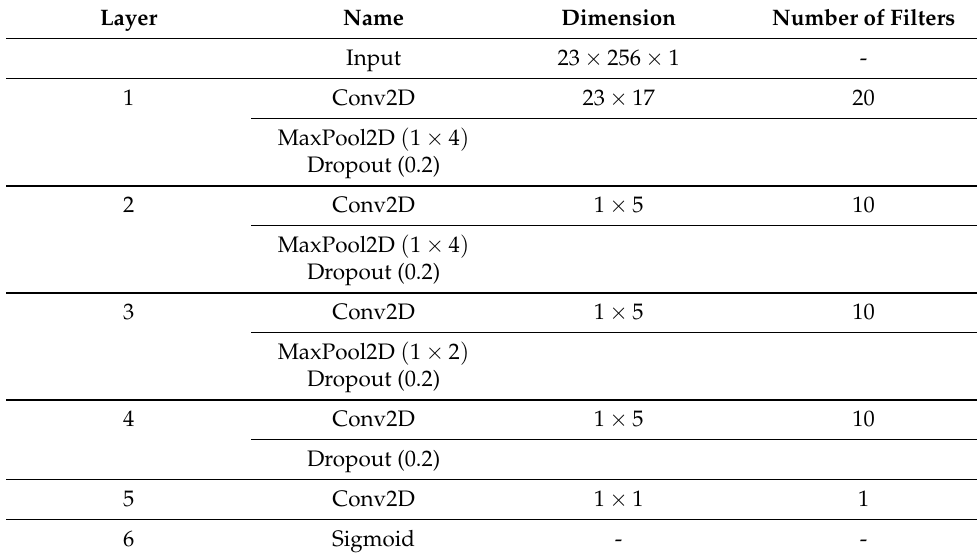
Table A1. Structure of the CNN, dimensions, and number of filters.